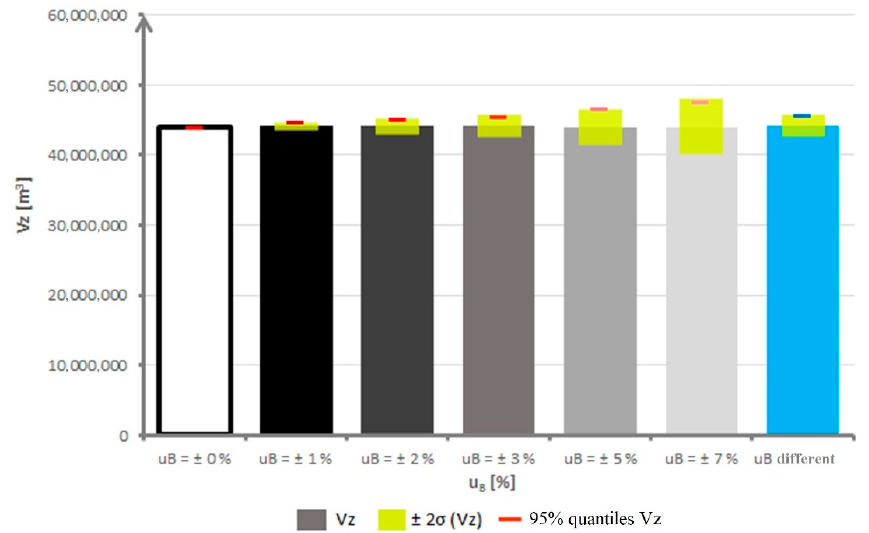
Figure 6. Bar chart of the resulting optimized storage volumes μ ( V Z ) of the Vír I reservoir for ±2 σ ( V Z ) and 95% quantiles of the tested input uncertainties u B .